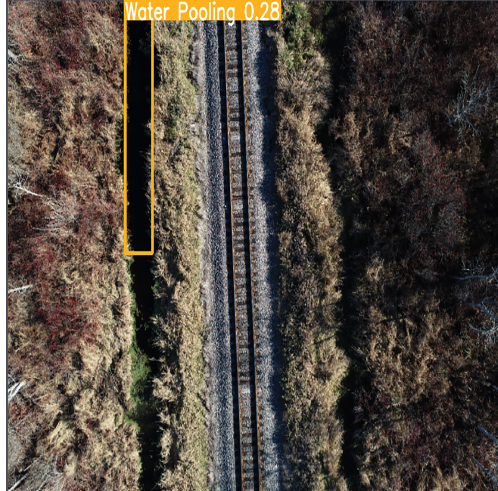
Figure 23. Negative water pooling